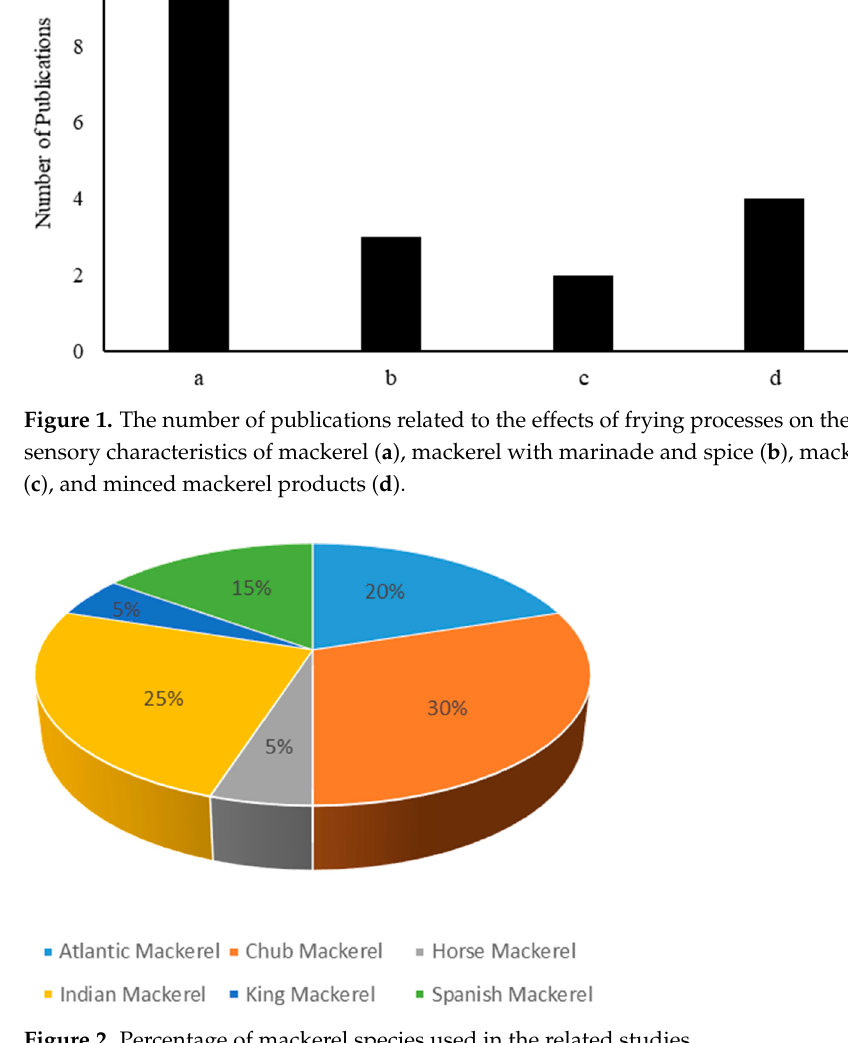
Figure 2. Percentage of mackerel species used in the related studies.